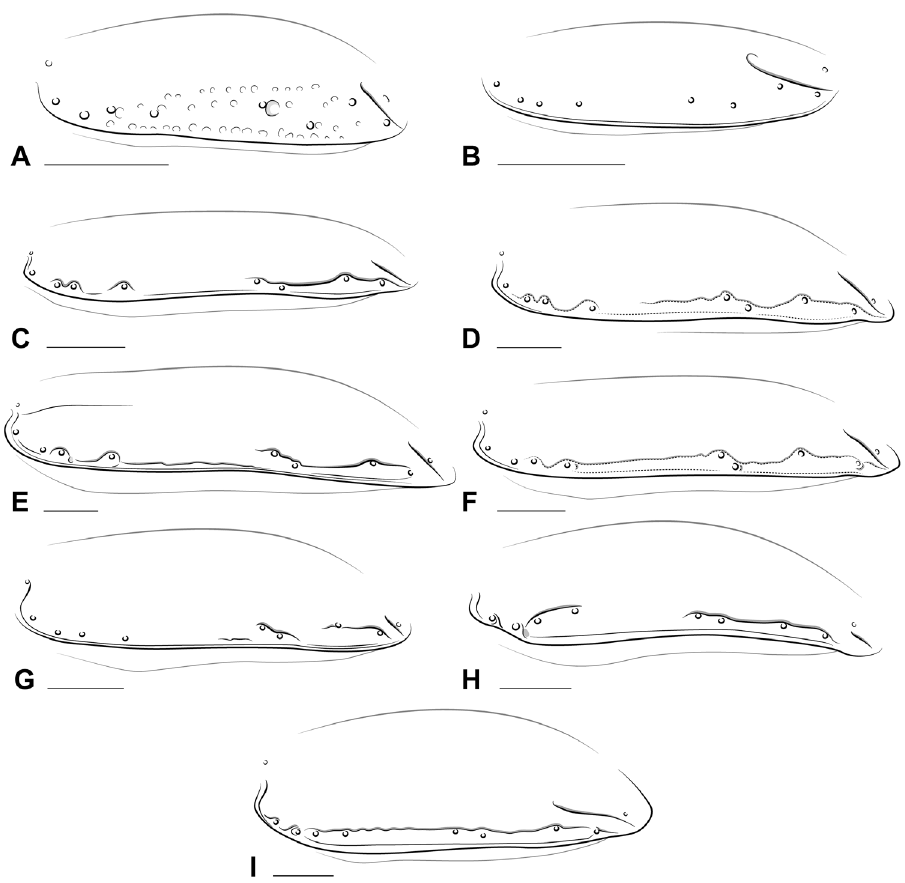
Figure 4. Illustrations of left elytron, lateral view, showing variation in the form of the 8 th elytral in- terneur (other interneurs not shown) among newly described taxa. A Stigmatachys uvea (holotype, ♀ ) B Polyderidius sp. C Nothoderis sp. D Meotachys ( Scolistichus ) riparius ; E Meotachys ( Hylotachys ) ballorum ; F Elaphropus ( Ammotachys ) marchantarius G Elaphropus ( Idiotachys ) acutifrons H Elaphropus ( Nototachys ) occidentalis I Tachyxysta howdenorum . Scale bars = 0.25 mm. Elaphropus ( Ammotachys ) marchantarius sp.